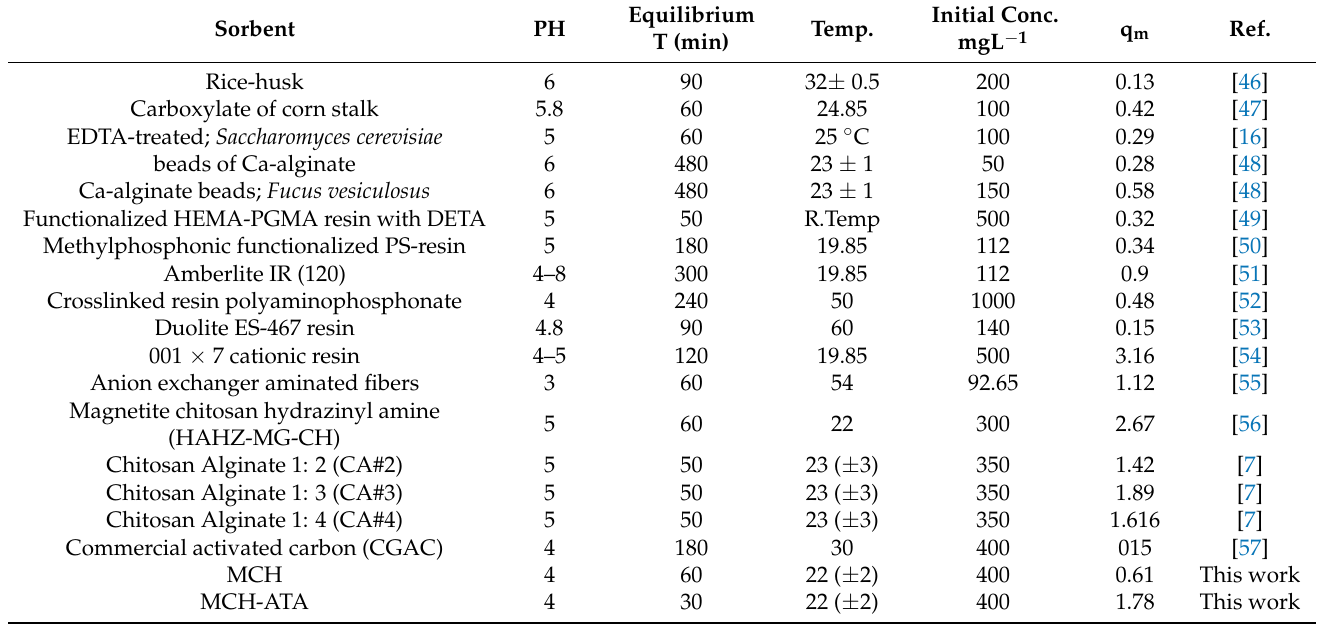
Table 4. Comparison of the sorption performance with sorbents (biosorbents and synthetic materials) in the literature for the MCH and